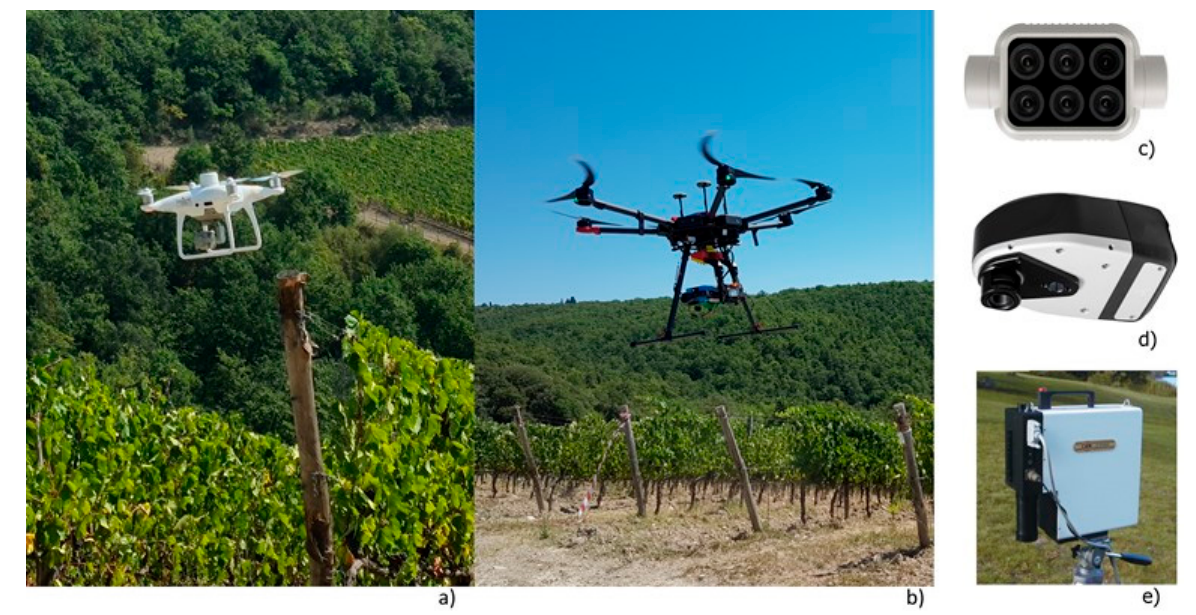
Figure 2. UAV platforms DJI P4M ( a ) and Matrice 600 Pro ( b ) used in this research to perform multispectral and hyperspectral sensing, respectively. Optical sensors used in this research: P4M multispectral camera ( c ), SENOP HSC-2 hyperspectral camera ( d ) and GER3700 spectroradiometer ( e ).